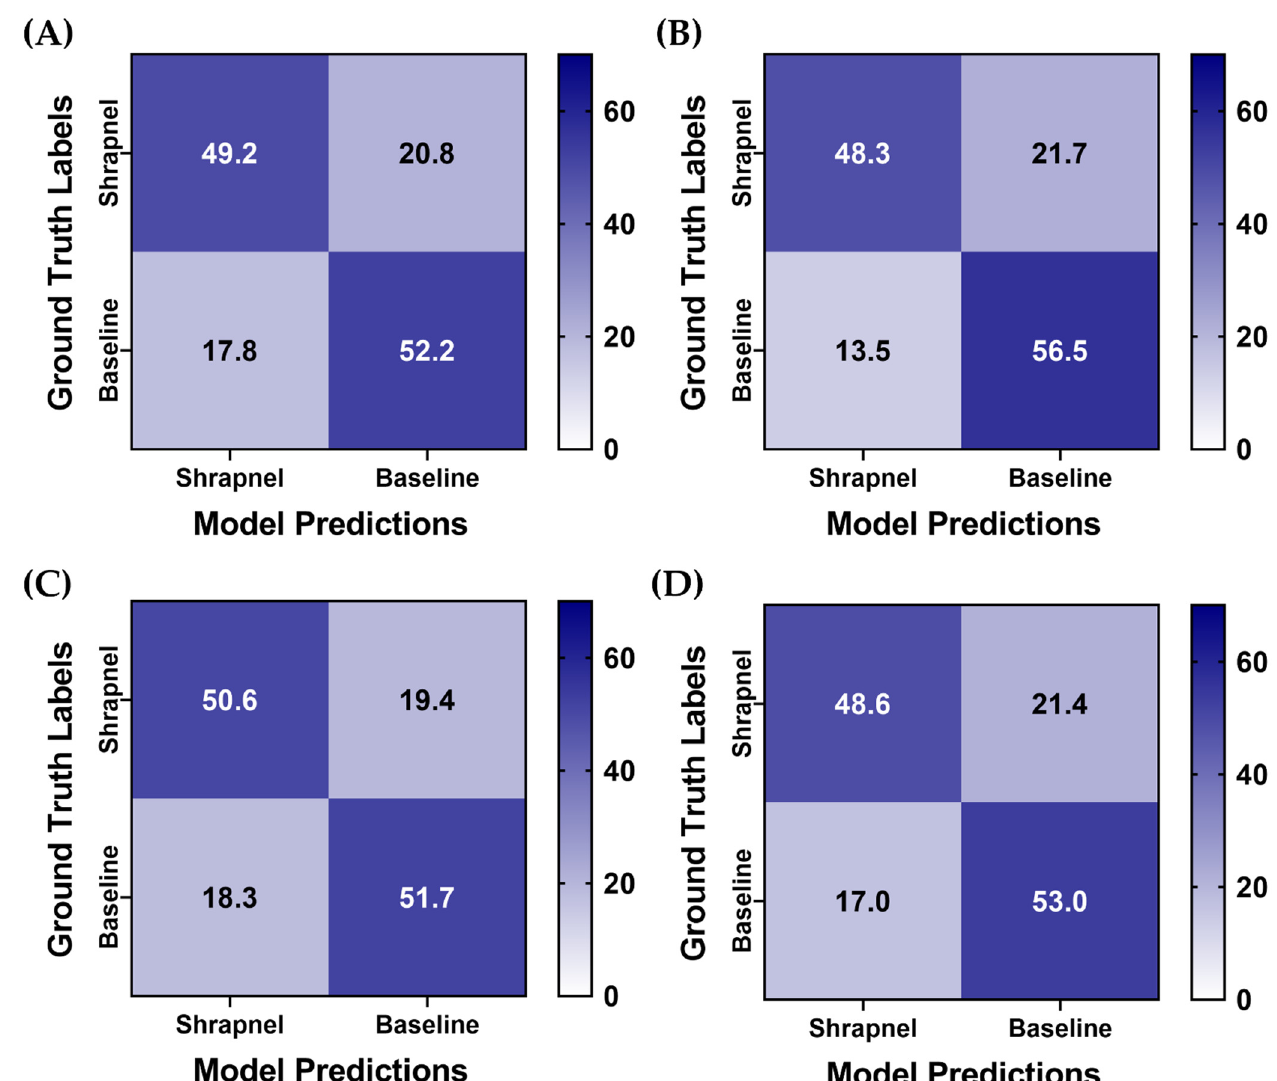
Figure 5. Data augmentation effects on blind test performance for ShrapML. Average confusion matrix results are shown for ( A ) No augmentation, ( B ) Affine augmentation only, ( C ) MixUp augmentation only, ( D ) Both affine and MixUp augmentations. Results are averaged for three training replicates for five LOSO holdout runs. A total of 70 shrapnel and 70 baseline images were used for each blind test run.